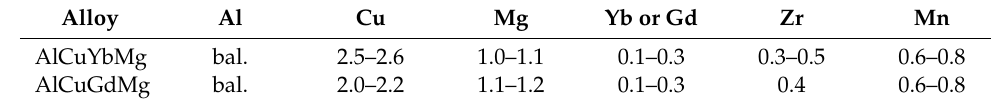
Mg-free alloys [24].